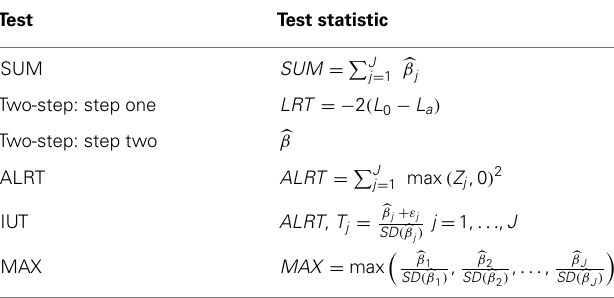
Table 2 | Comparison of five global test